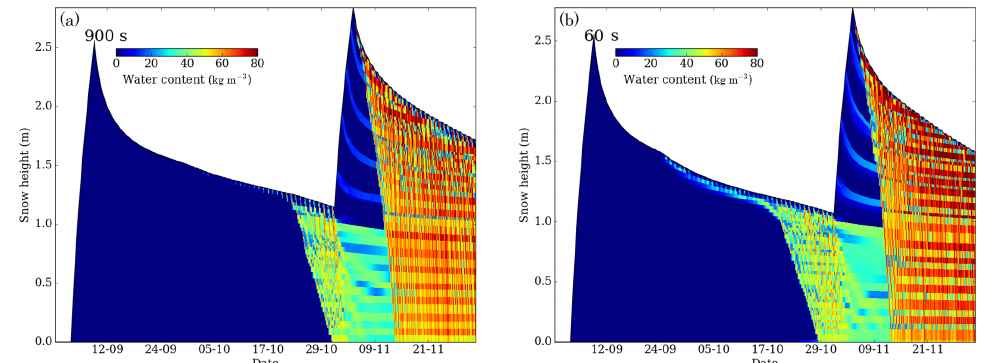
Figure 9. Crocus output for simulated forcing showing different time steps: (a) T Crocus = 900s (15min), (b) T Crocus = 60s both plots use the free-flowing bottom boundary with prewetting set to θ min = 10 − 5 . The 60s simulation has water at the bottom of the snowpack 4 days before the 900s simulation.